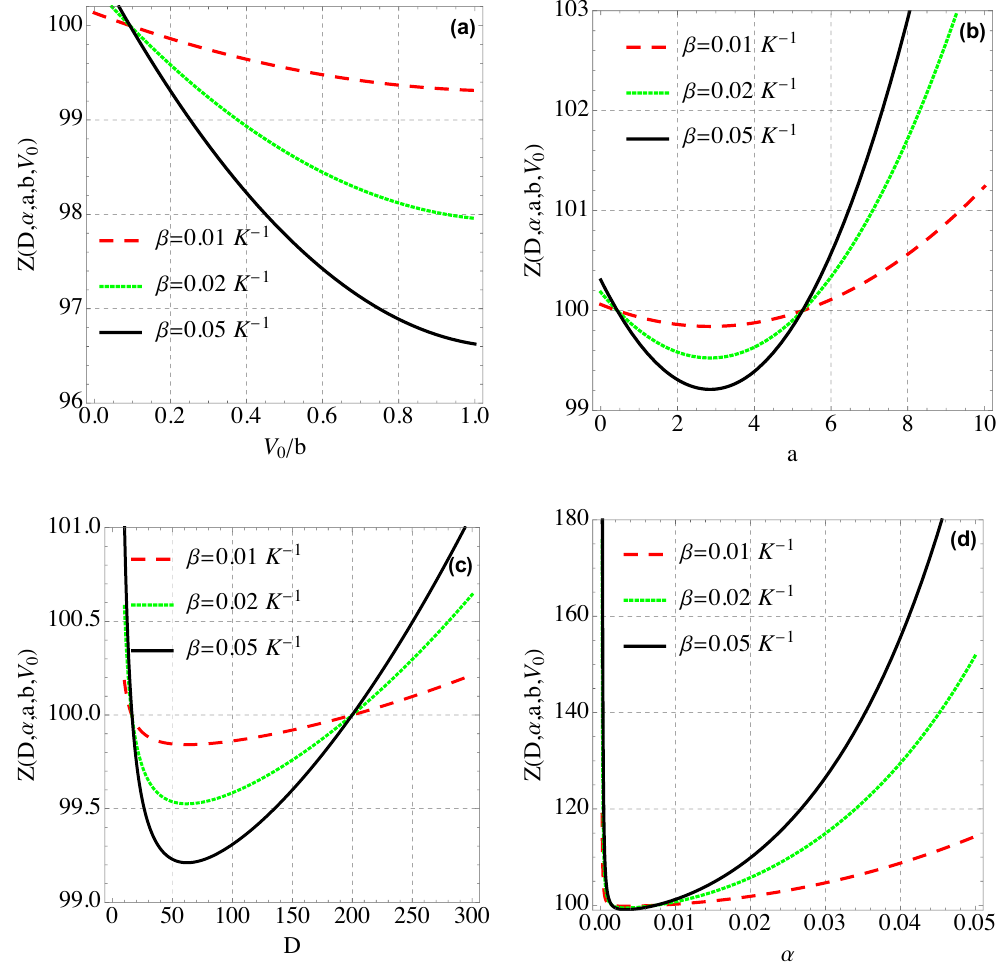
Figure 2. Partition function Z ( β ) as a function of; ( a ) V 0 / b , ( b ) parameter a , ( c ) D and ( d ) screening parameter α for different values of β = 0.01K − 1 (red curve), 0.02K − 1 (green curve), β = 0.05K − 1 (black